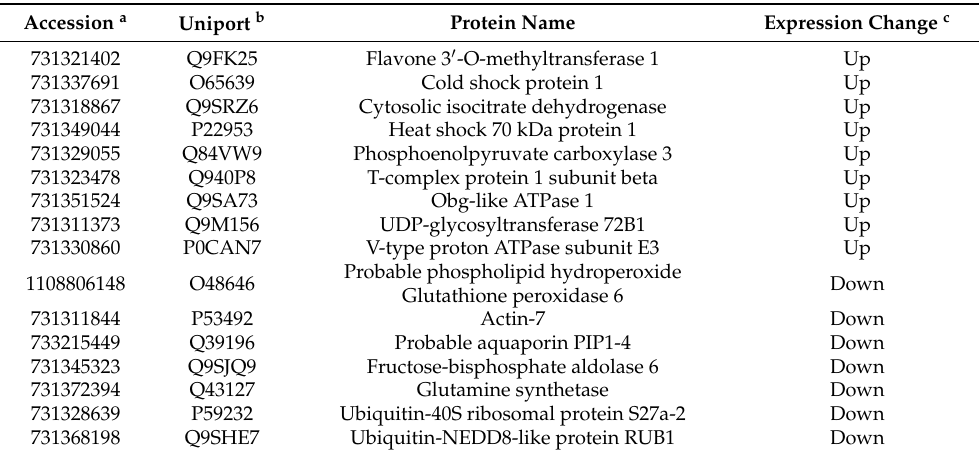
Table 1. Up/downregulated expression of ubiquitinated proteins in both the 200 mM and 400 mM NaCl treatment